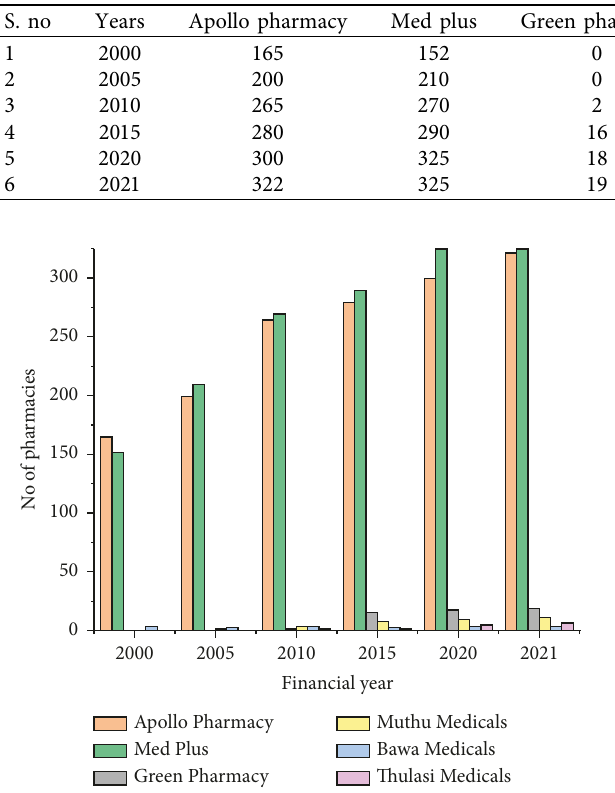
Table 2: Data for the growth of different pharmacies in Chennai from 2000 to 2021.